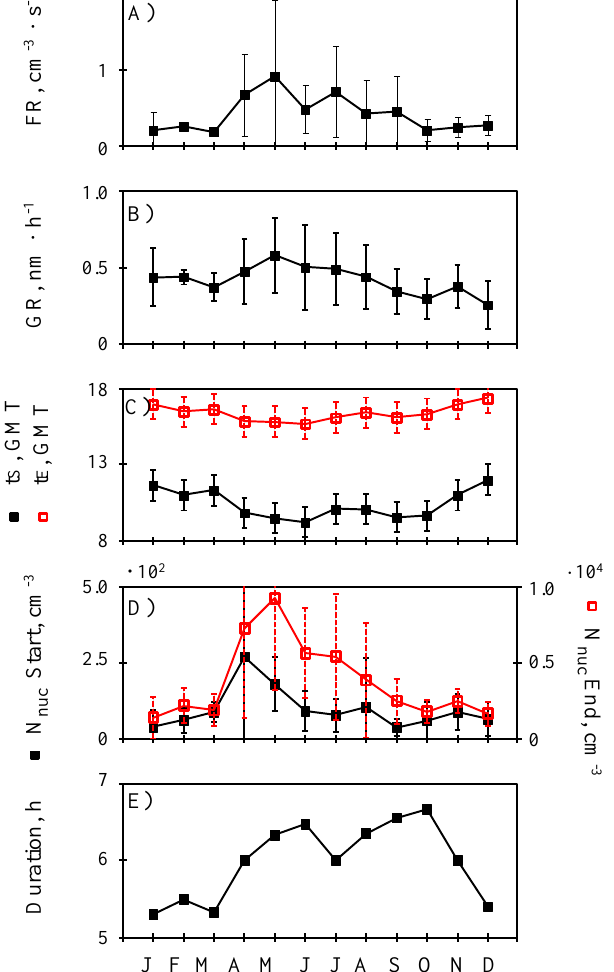
Fig. 7. Monthly mean ± standard deviation values, during Ia episodes, of (A) formation rates (FRs), (B) growth rates (GRs), (C) start ( t S ) and end ( t E ) time of the events, (D) nucleation par- ticle concentration at the start ( N nuc start) and burst peak of the event ( N nuc end), and (E) duration of events.